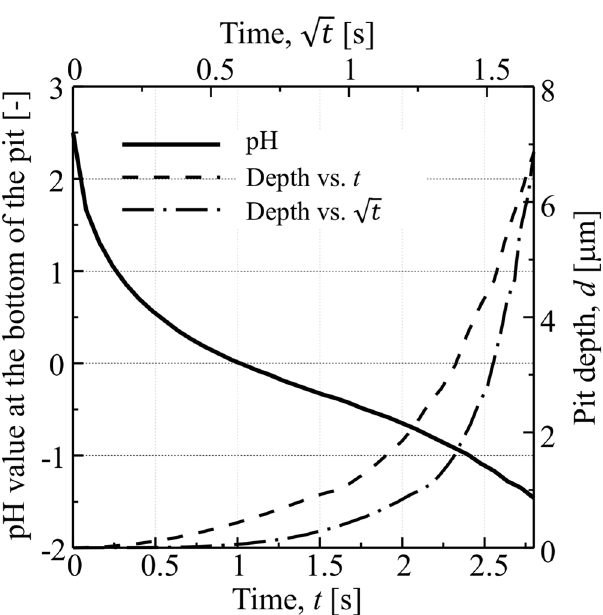
Figure 7. Variations in the pit depth and the local pH at the bottom of the pit during the pitting